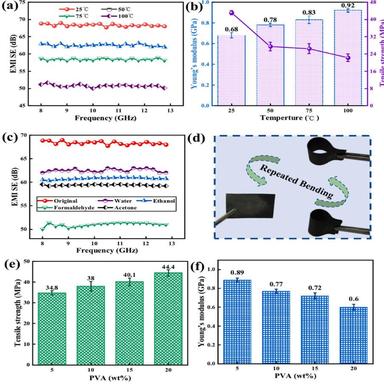
(a, b) The EMI SE and mechanical properties of materials under different temperature conditions. (c) The EMI SE of composite materials after being immersed in different organic solvents (water, ethanol, acetone, formaldehyde) for 6 h. (d) The flexible demonstration of AMA composite materials. (e, f) Influence of PVP content on the Young's modulus and the elongation at break of the composite.